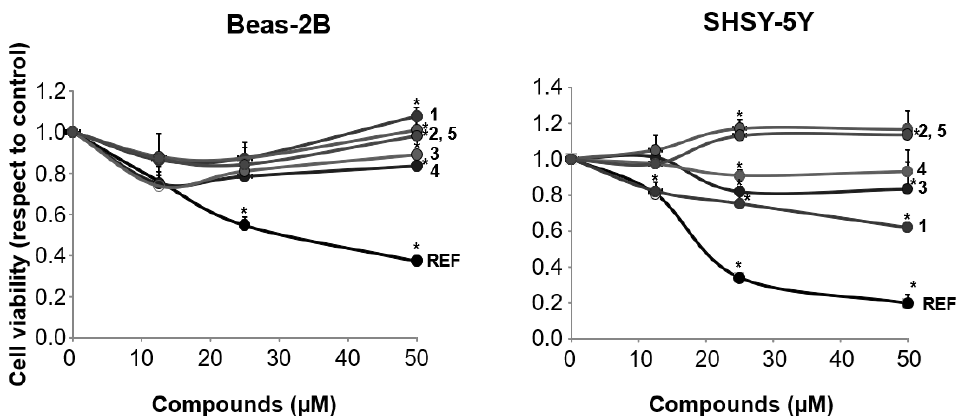
Figure 2. Effects of compounds 1 – 5 on cell viability in non-cancer cells (REF = resveratrol) BEAS-2B (human bronchial epithelium) and SHSY-5Y (neuronal cells). Values expressed as mean ( n = 6) ± SD. * p < 0.01.